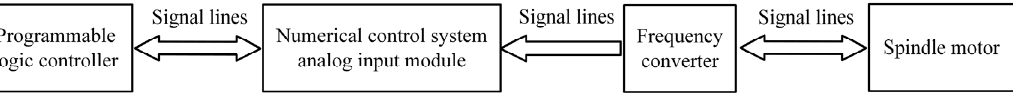
Figure 5. Spindle motor acquisition module.